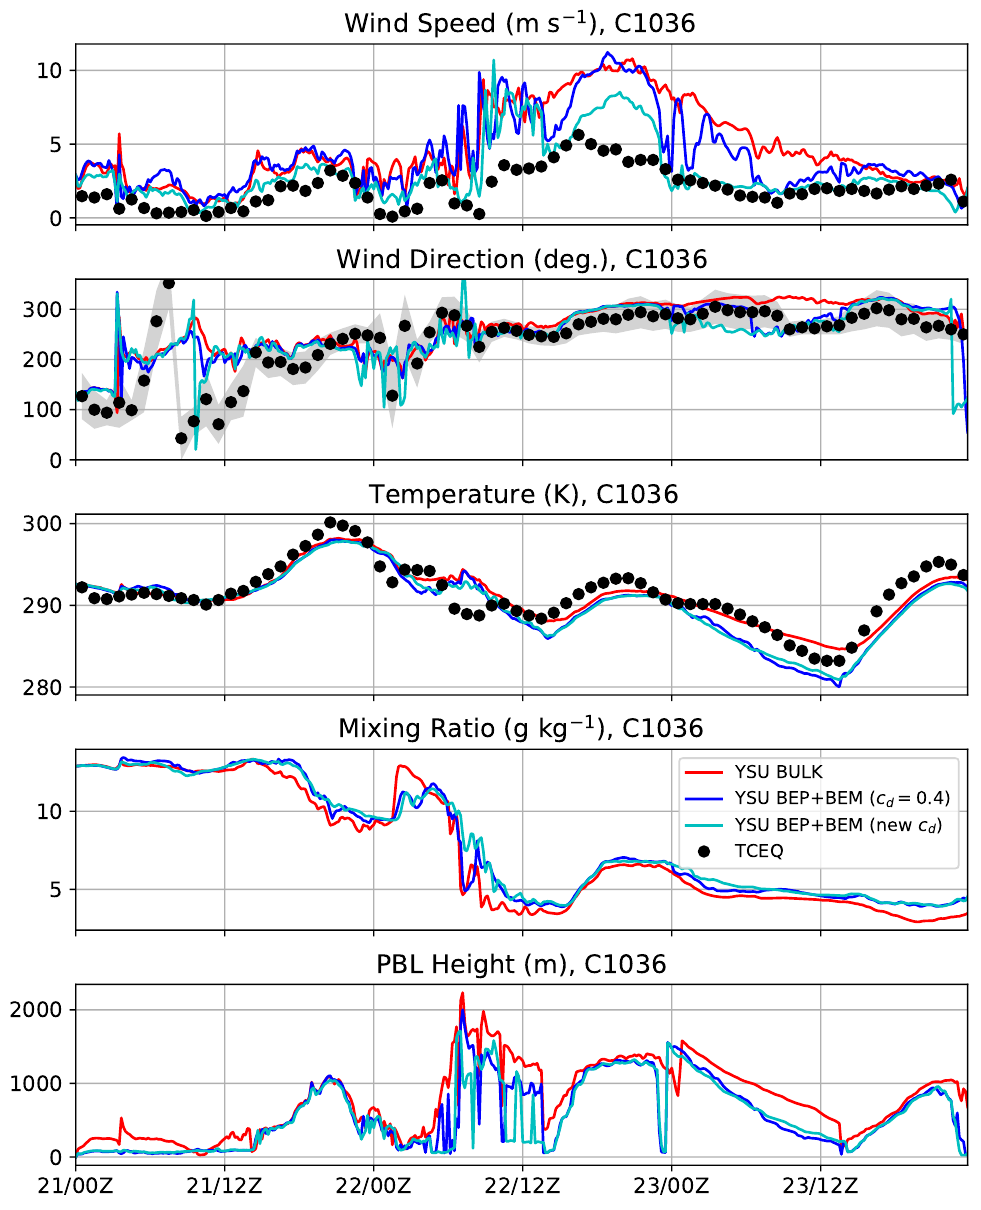
Figure 9. Same as Figure 7 but at LIR station